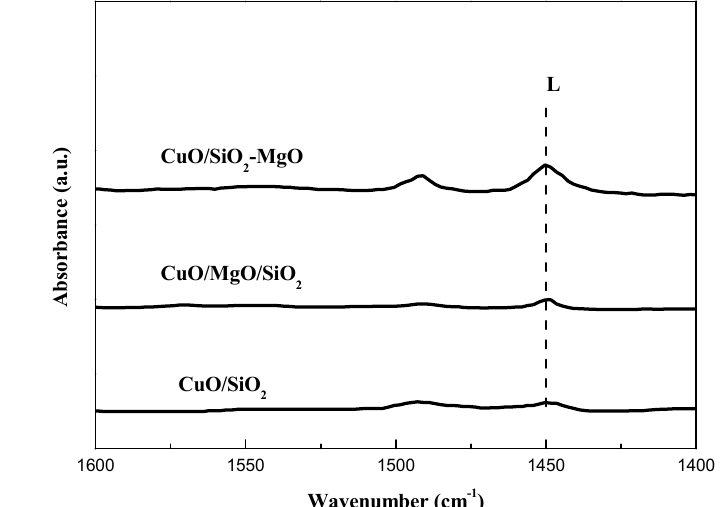
Figure 10. Py-IR spectra of catalysts.